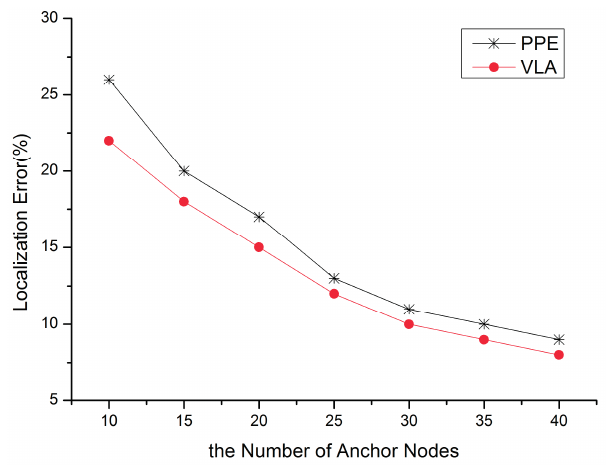
Figure 6. Anchor density vs. localization